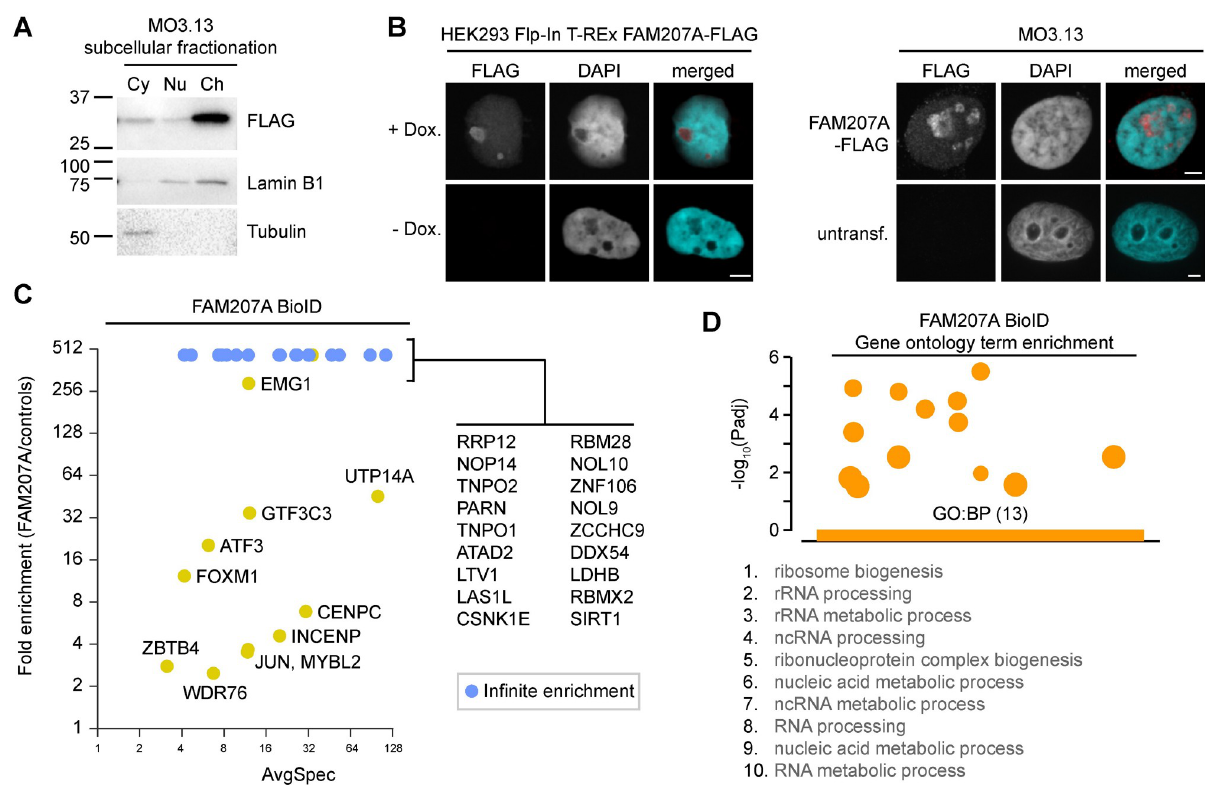
Fig 2. FAM207A is a nucleolar protein involved in ribosome biogenesis. A: Subcellular fractionation of MO3.13 cells expressing FLAG-FAM207A. B: Immunolabeling of exogenous FAM207A in HEK293 Flp-In and MO3.13 cells. C: Fold enrichment of FAM207A BioID prey (BFDR � 5%, SAINT [103]) over negative controls. Data were obtained from biological duplicates. D: Gene ontology terms represented in the FAM207A BioID. Cy— cytoplasm; Nu—nucleus; Ch—chromatin. Scale bars = 4 μ m.